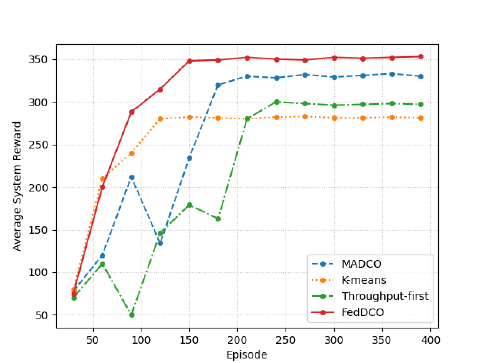
Figure 3. The reward curve of the four algorithms in the training process.